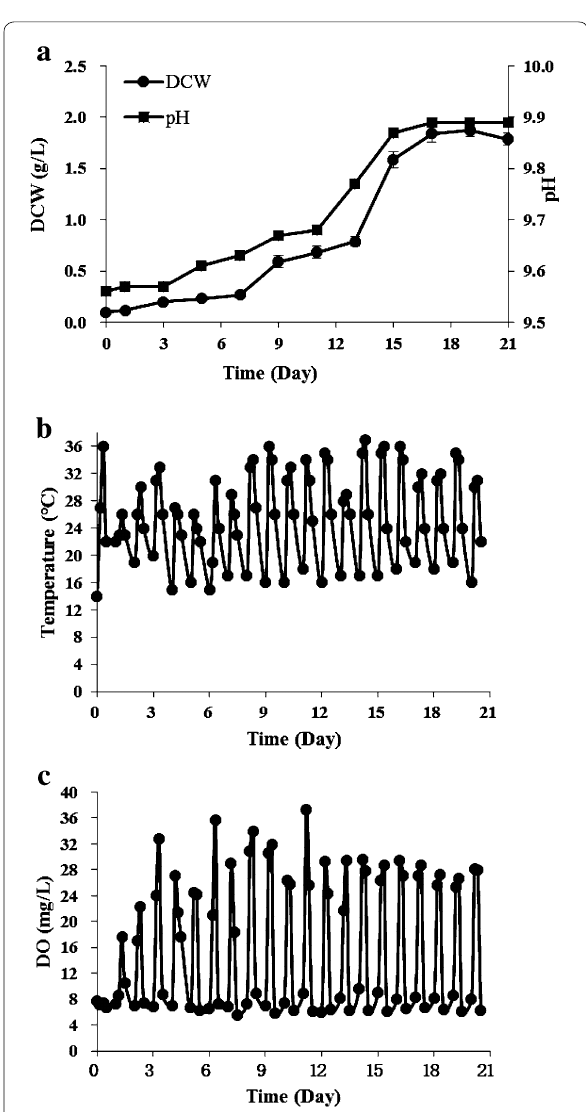
Fig. 7 Outdoor culture of Euhalothece sp. ZM001 with 1 m 2 plastic bag on rocking platform driven with water power at rocking cycle of 60 s: a biomass production and pH change; b culture temperature; c